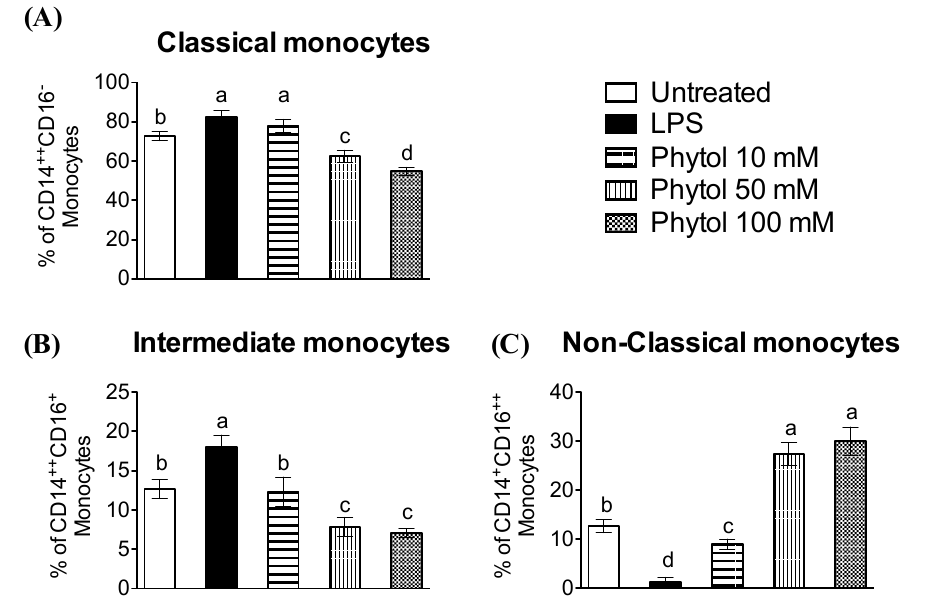
Figure 2. Effect of phytol on monocytes cells. FACS analysis (MFI) data of CD14 and CD16 as monocyte surface markers after 24 h treatment in the presence or absence of 100 ng/mL of LPS and phytol at 10, 50, or 100 mM. ( A ) Classical monocytes CD14 ++ CD16 − , ( B ) intermediate monocytes CD14 ++ CD16 + , and ( C ) non-classical monocytes CD14 + CD16 ++ . Values are shown as means ± SD ( n = 3) and, when marked with different letters, are significantly different ( p < 0.01).